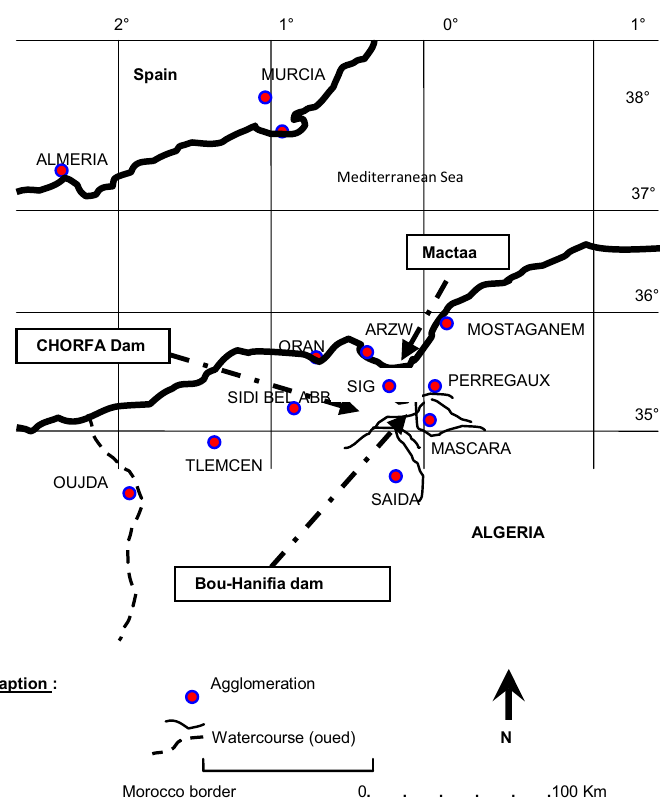
Fig. 1 Geographical location of Chorfa